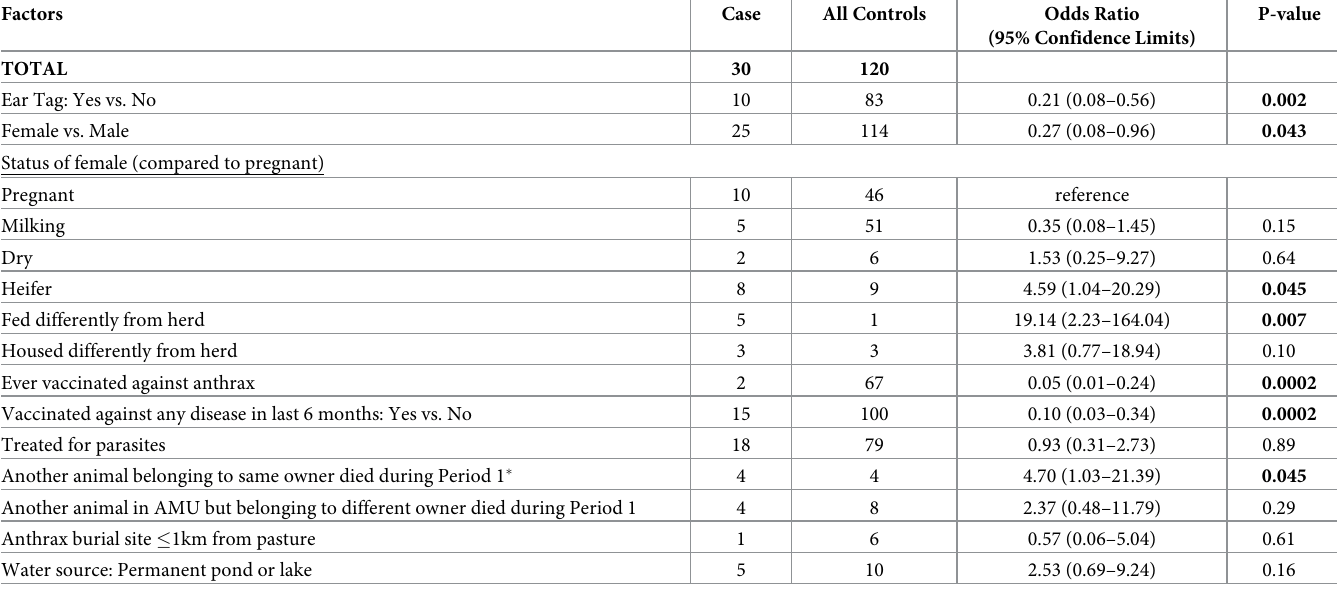
Table 2. Factors potentially associated with anthrax by univariate conditional logistic regression analysis: Cases vs all